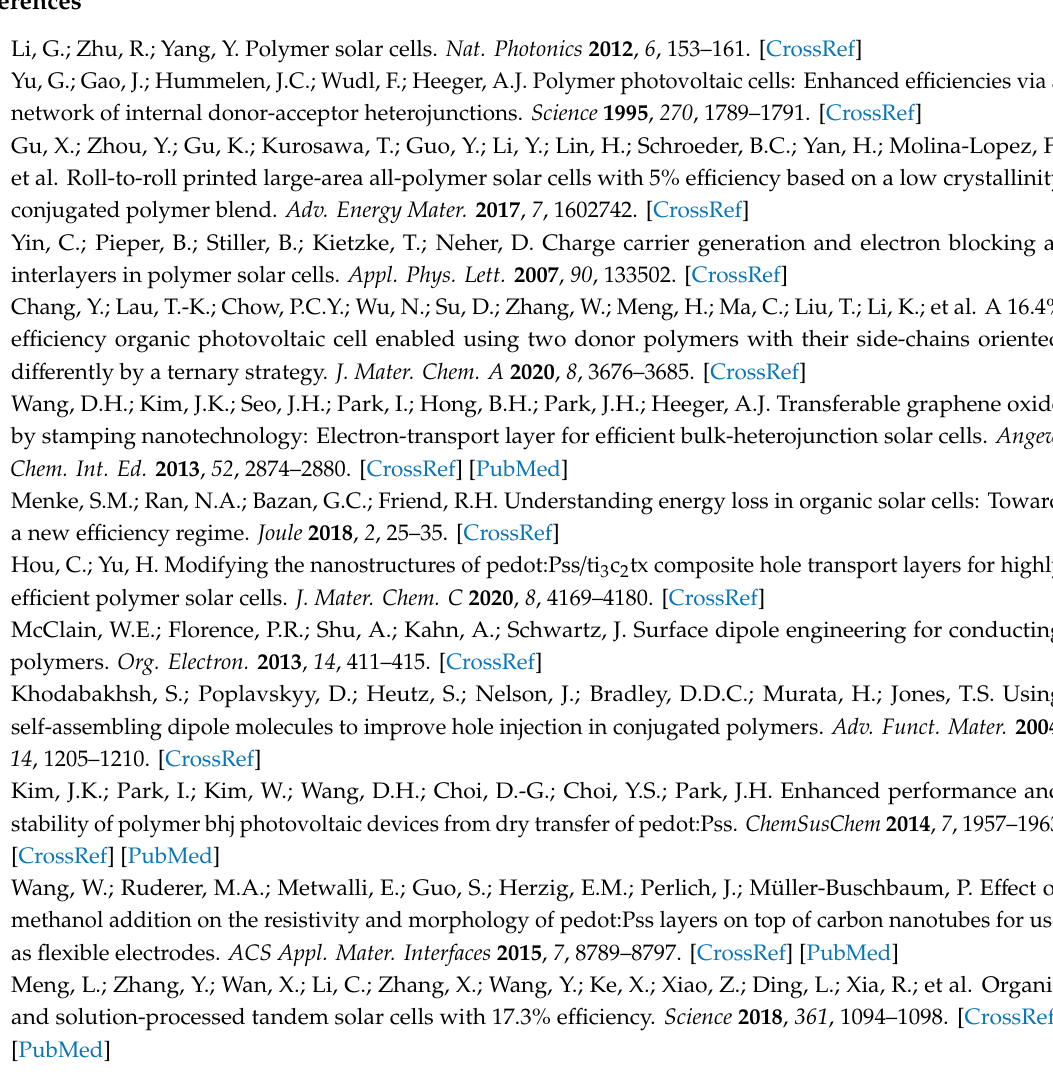
Figure S1. SEM images of NP-V2O5 films prepared by using various concentrations of PEG (a) 10 mM, (b) 20 mM, and (c) 80 mM. Figure S2. Cross-section SEM images of (a) bare V2O5 and (b) NP-V2O5 prepared using 40 mM PEG. Figure S3. Photocurrent density–voltage curves of the OSCs with NP-V2O5 HTL prepared using various concentrations of PEG from 10 mM to 80 mM. Figure S4. Contact angle and AFM images of water droplets (12 µ L) on the surface of (a) PEDOT:PSS and (b) NP-V2O5 films prepared using 40 mM PEG. Table S1. Summary of the device performance